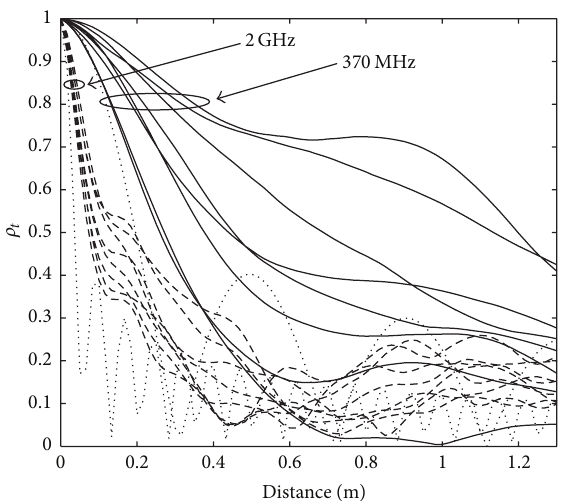
Figure 3: Spatially averaged temporal correlation function for the intersection region at 370 MHz (solid lines) and 2GHz (dashed lines). The model correlation function at 30km/hr is also shown (dotted